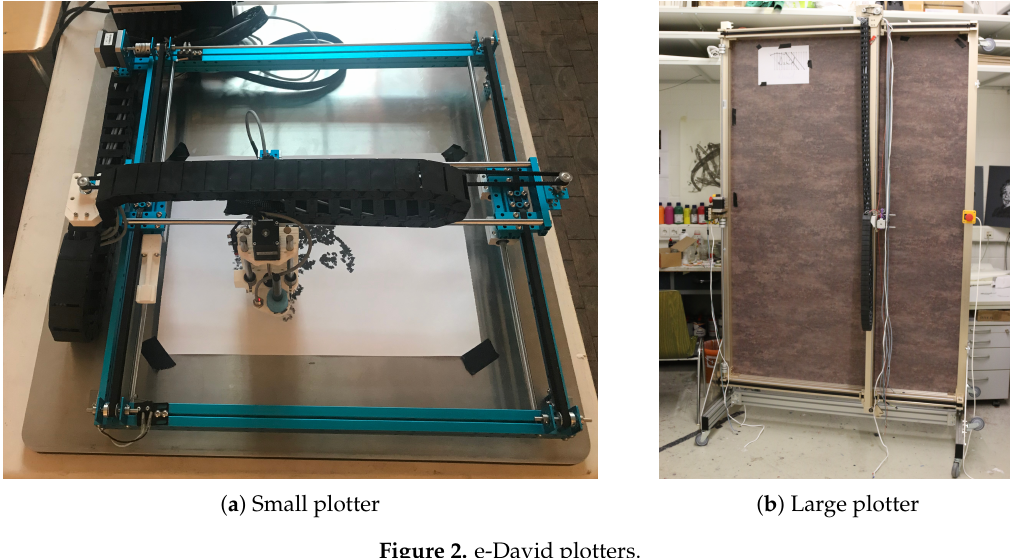
Figure 2. e-David